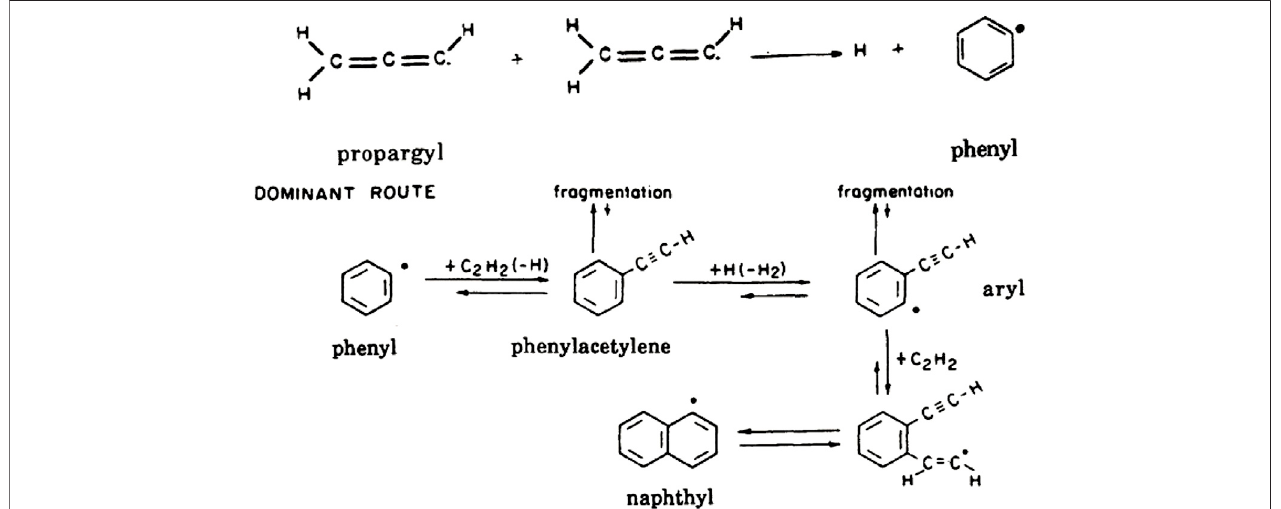
FIGURE 8 | Top: One important route toward closure of the fi rst ring. The reaction of two propargyl radicals forming the phenyl radical ( C 6 H 5 ) . Bottom: Further growth consists of sequential steps of radical-site formation followed by acetylene addition, followed by ring closure. Figure adapted from Cherchneff et al. (1992)